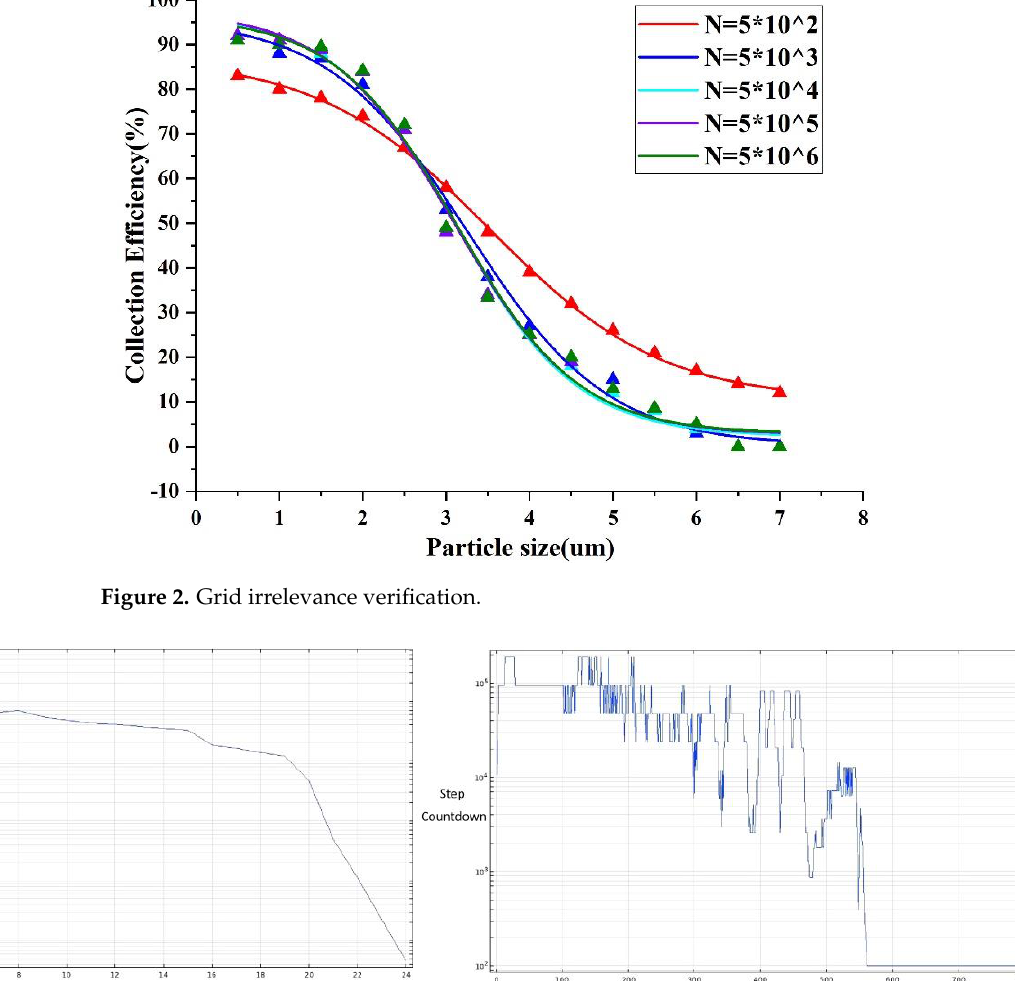
Figure 3. ( a ) Steady − state solver; ( b ) Transient solver.